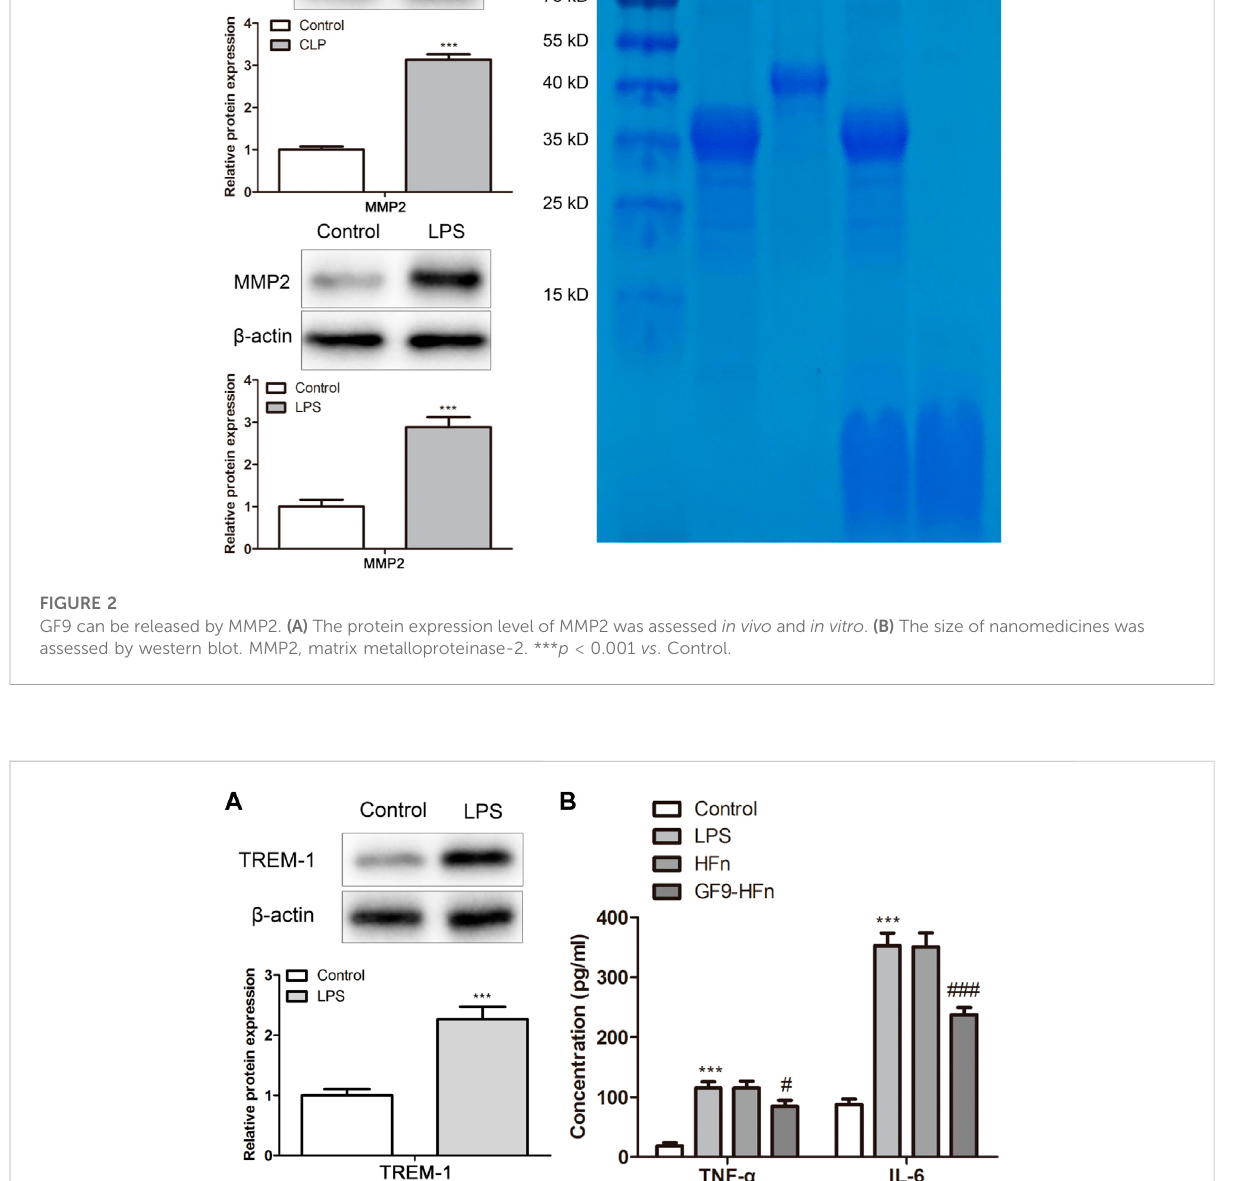
E. coli was signi fi cantly decreased by GF9-HFn/Str and HFn/ Str compared with CLP, HFn, and GF9-HFn ( p < 0.01; Figure 7B). Compared with the expression levels of TNF- α